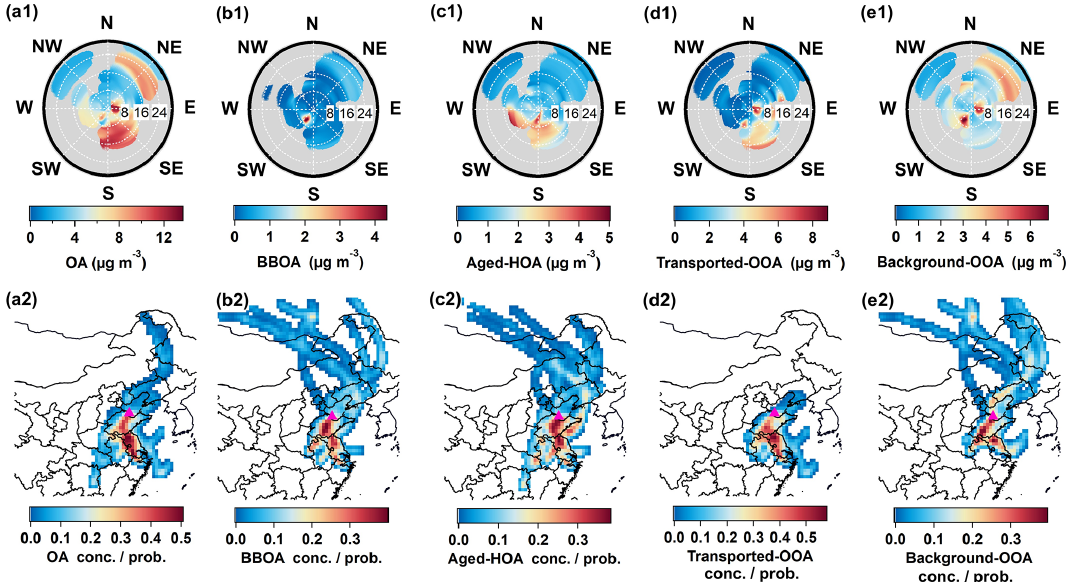
Figure 5. Bivariate polar plots and PSCF results of organic components, including (a1, a2) total OA; (b1, b2) BBOA; (c1, c2) aged-HOA; (d1, d2) transported-OOA; (e1, e2) background-OOA. The unit of wind speed is kmh − 1 .